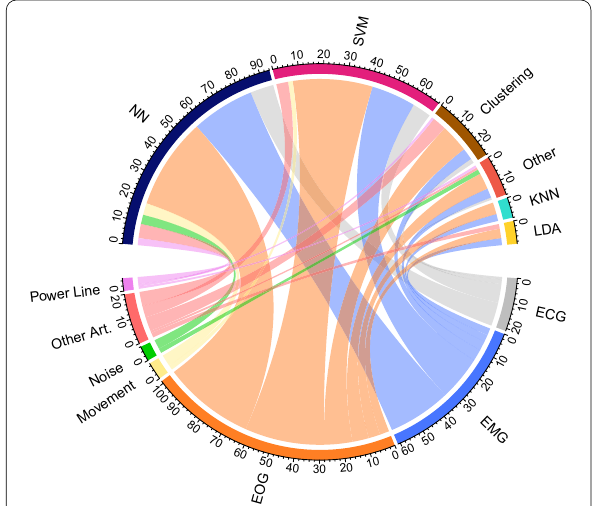
Fig. 8 Frequency of artefacts and the used machine learning methods